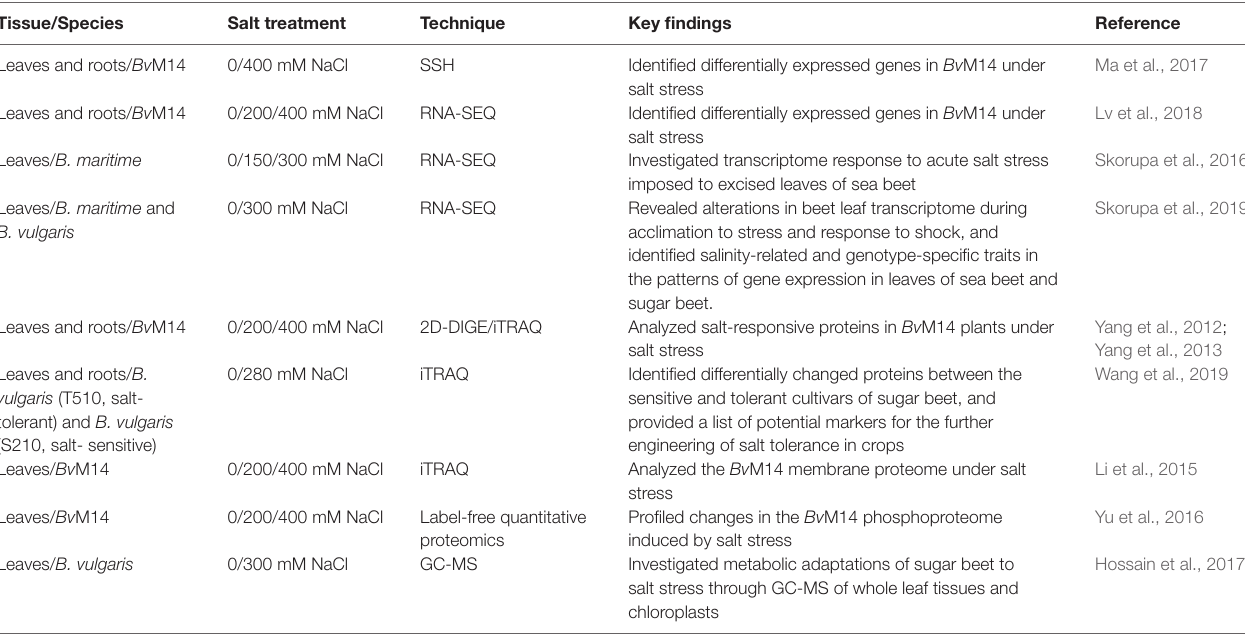
TABLe 1 | Major ‘omic studies of salt stress tolerance in sugar beet using different technological platforms. Tissue/Species Key